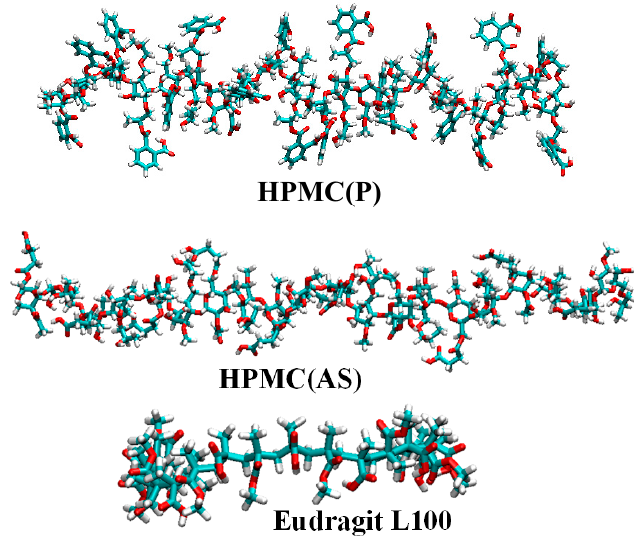
Figure 2. Atomic structures of polymer chains. Color code: O, red; N, blue; C, cyan; H, white.